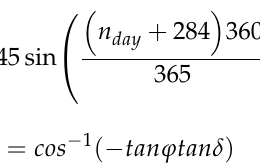
Figure 3. Triangular correlation heatmap of the studied variables.